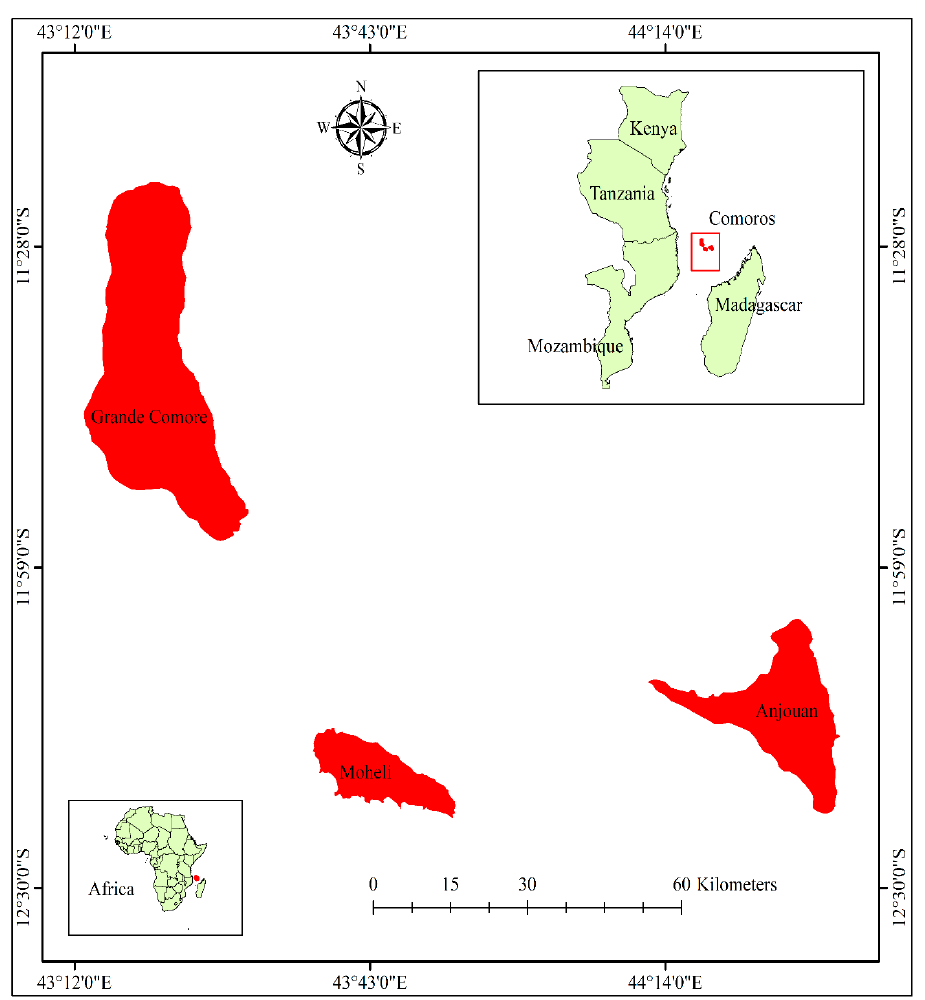
Figure 1. Map of the study are in red.